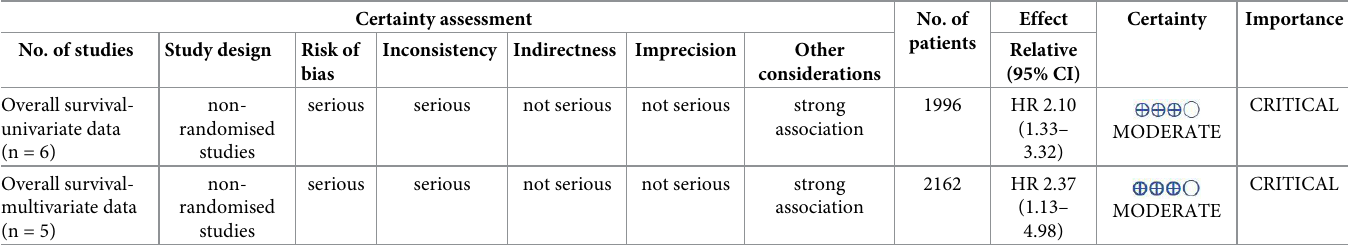
Table 3. GRADE evidence profile: Sarcopenia vs. non-sarcopenia for OS in rectal cancer